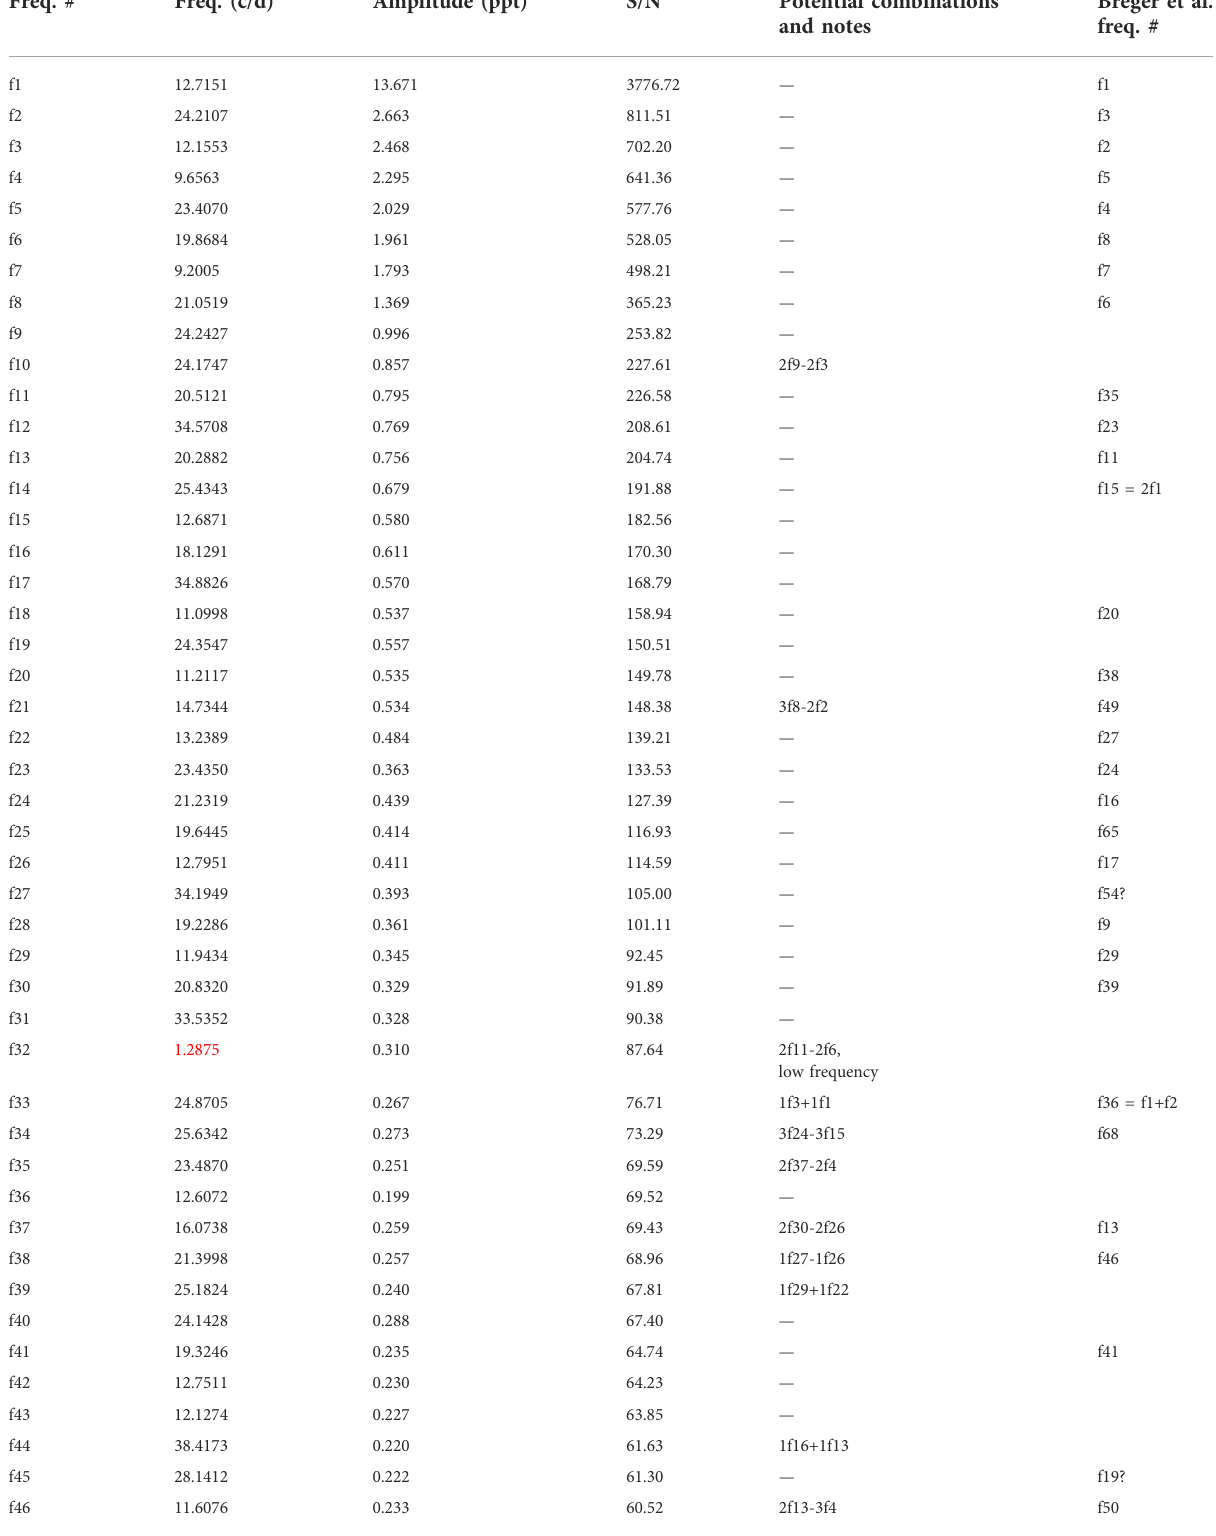
TABLE 2. 100 highest S/N FG Vir TESS frequencies. Low frequencies between 0.3 and ~3 c/d are highlighted using red font. The calculated uncertainties in TESS frequencies and amplitudes, respectively, are 3.79×10 − 4 c/d and 9.82 ppm. Freq. # Freq. (c/d) Amplitude (ppt) S/N Potential combinations